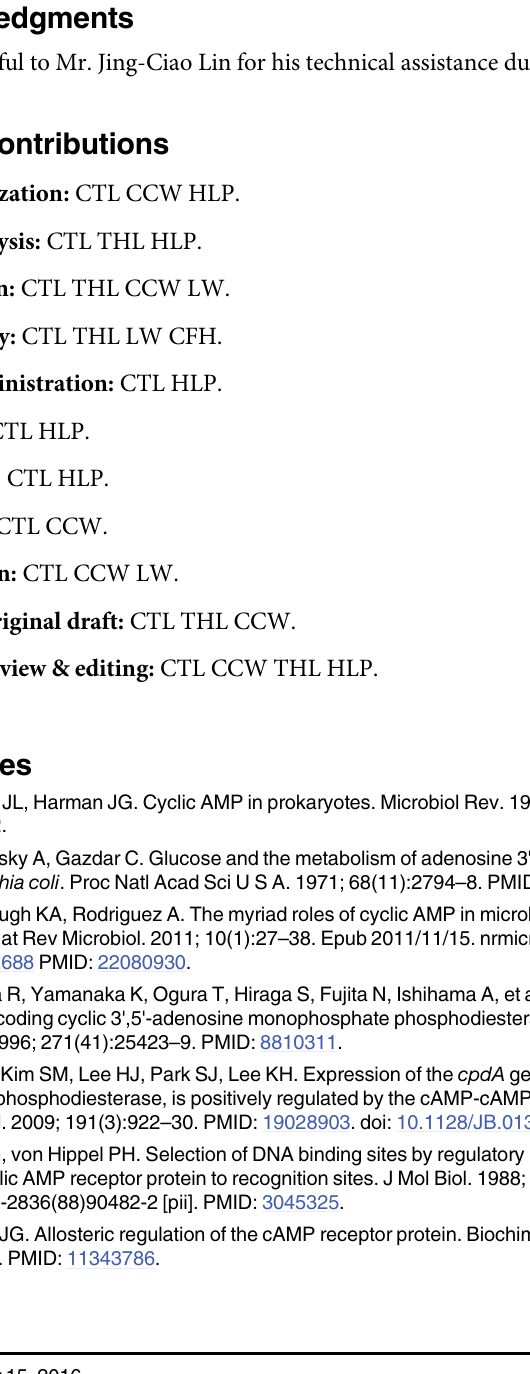
S1 Table. Bacterial strains and plasmids used in this